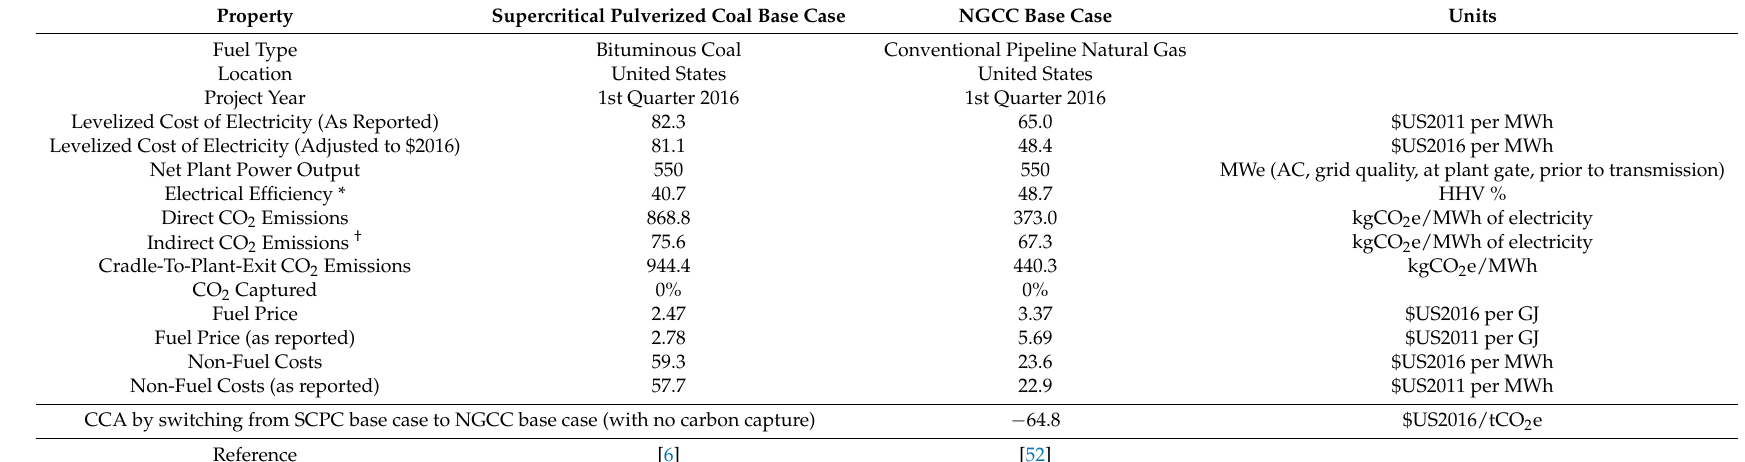
Table 1. Base cases for coal and gas, representing the current commercial